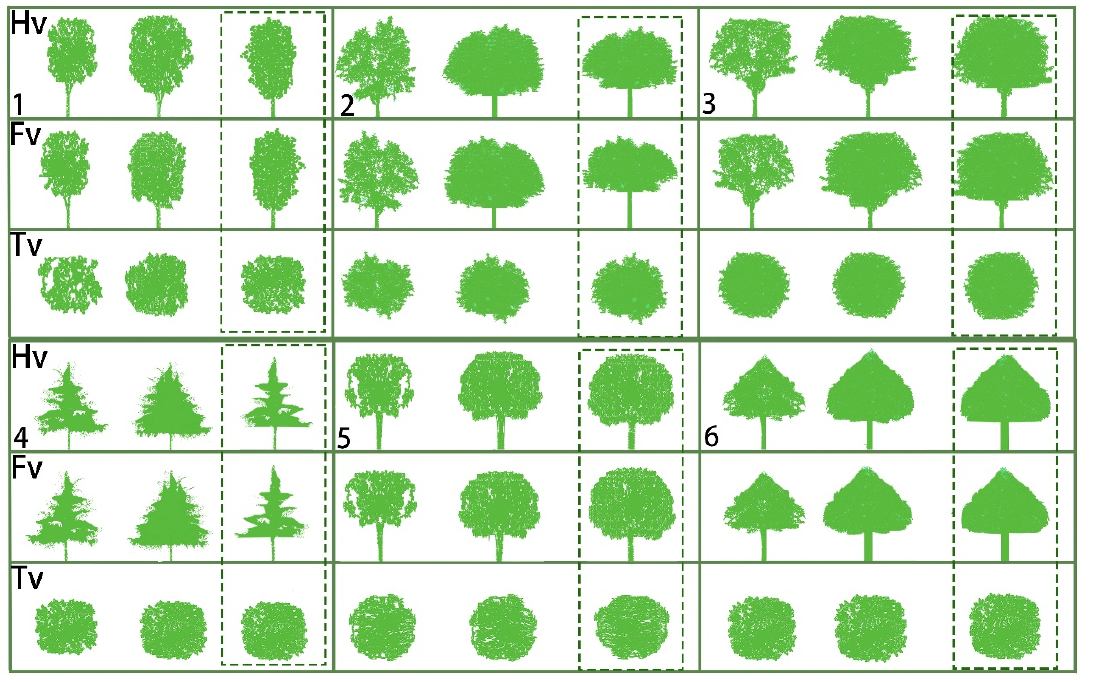
Figure 4. Three-view geometrical fitting of street tree.